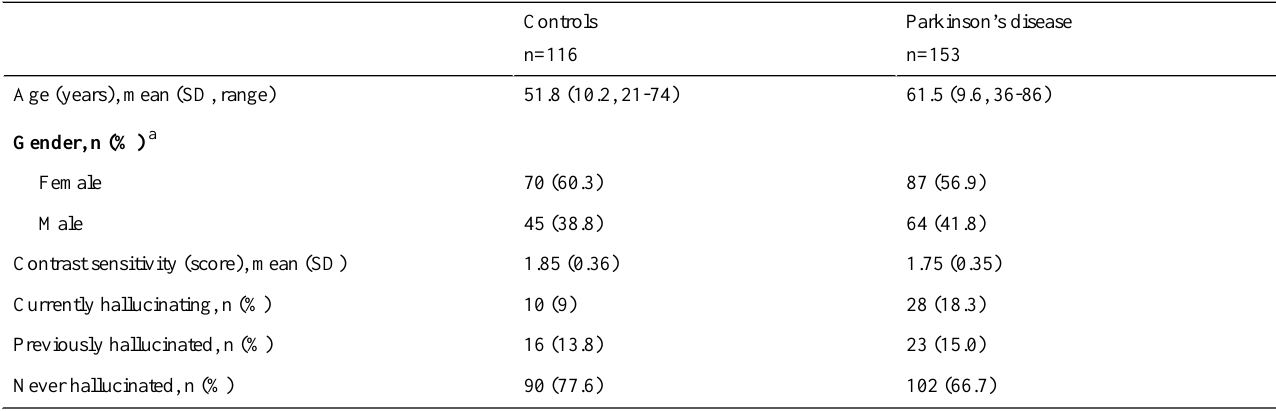
Table 1. Parkinson’s and control group characteristics